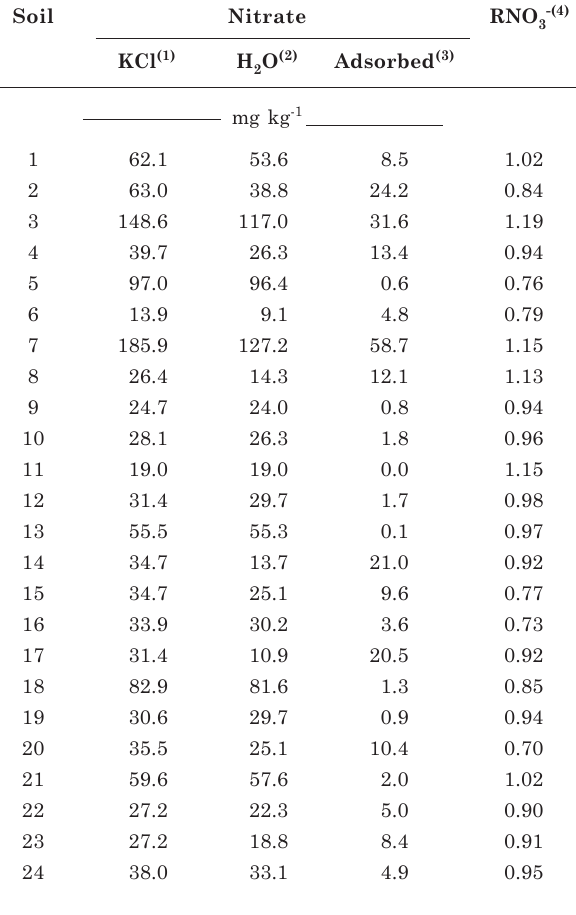
Table 3. Soil contents and retardation factors of nitrate in the studied